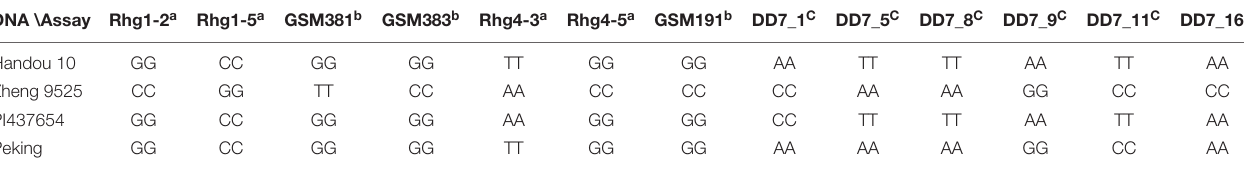
TABLE 6 | Detection and analysis of soybean germplasm by KASP markers located at major QTL intervals ( SCN_8_2 , SCN_18_6 , and SCN_7_1